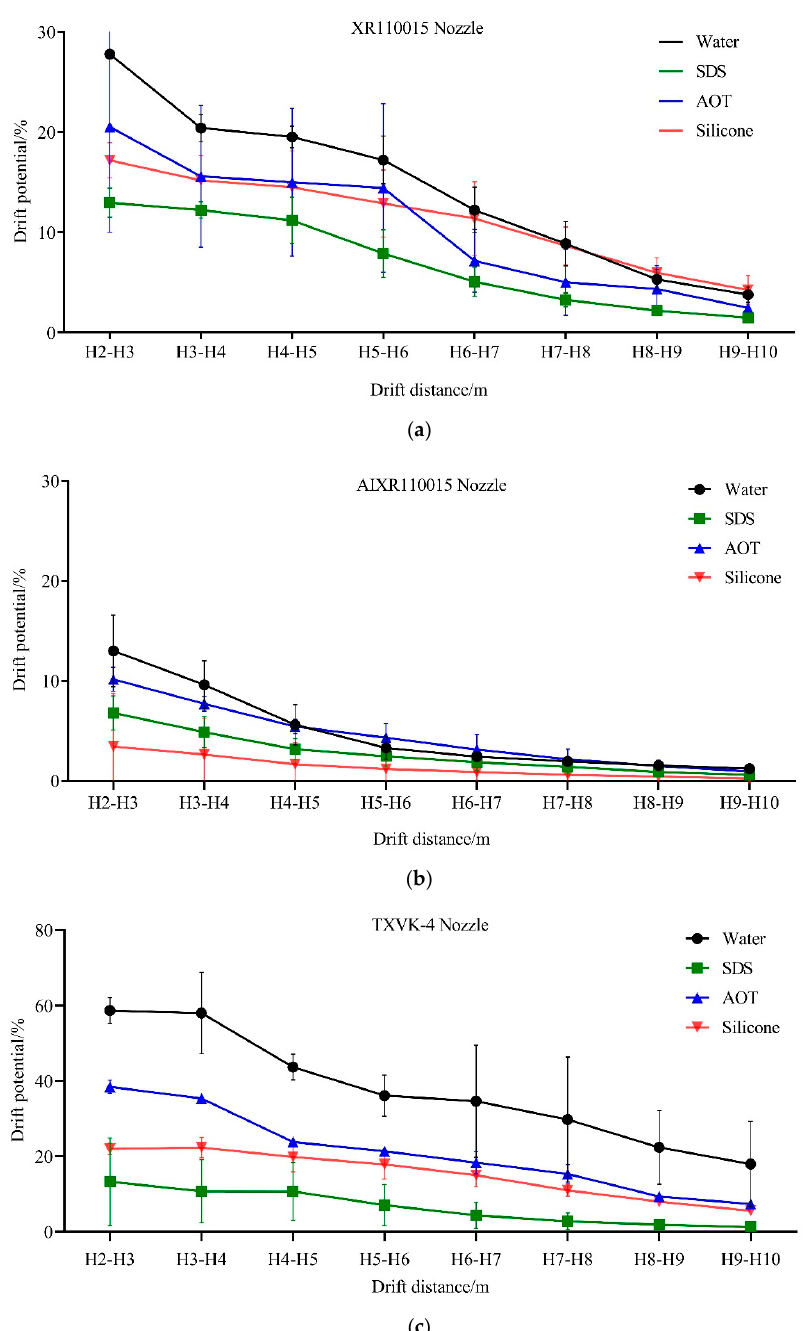
Figure 12. Drift potential curves in the area of 2 m to 10 m downwind for different spray solutions with the ( a ) XR, ( b ) AIXR, and ( c ) TXVK at a driving speed of 2 m/s. The abscissa represented the drift potential in the area between two adjacent sampling lines horizontally.